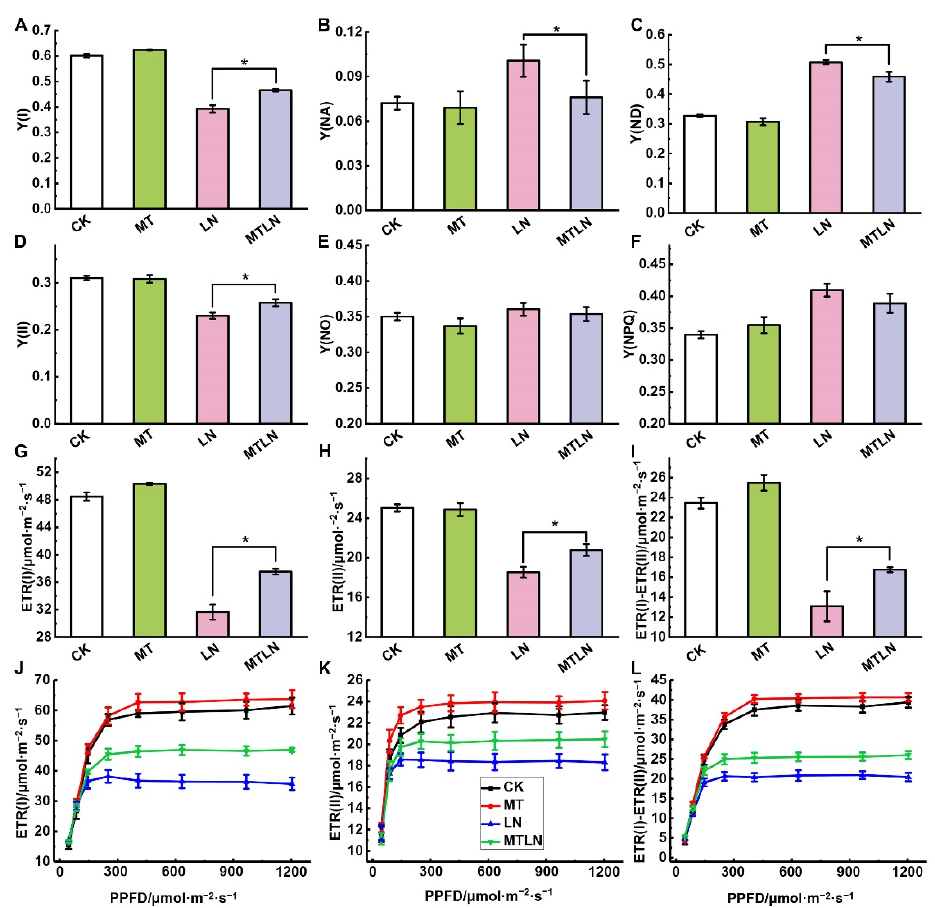
Figure 3. The effect of exogenous melatonin on light energy distribution and electron transfer dynamics of tomato plants subjected to low night temperature. The photochemical quantum yield of PSI (Y(I)) ( A ); the quantum yield of non-photochemical energy dissipation due to acceptor-side limitation (Y(NA)) ( B ); the quantum yield of non-photochemical energy dissipation due to donor-side limitation (Y(ND)) ( C ); the effective photochemical quantum yield of PSII (Y(II)) ( D ); the quantum yield of non-regulated energy dissipation of PSII (Y(NO)) ( E ); the quantum yield of regulated energy dissipation of PSII (Y(NPQ)) ( F ); the electron transport rate through PSI (ETR(I)) ( G ); the electron transport rate through PSII (ETR(II)) ( H ); the rate of cyclic electron flow (CEF) around PSI (ETR(I)-ETR(II)) ( I ) under steady light. The rapid light response curves of (ETR(I)) ( J ); the rapid light response curves of (ETR(II)) ( K ); the rapid light response curves of (ETR(I)-ETR(II)) ( L ). Data are presented as the mean ± standard deviation of four to six independent biological replicates. * p -value < 0.05; student’s t